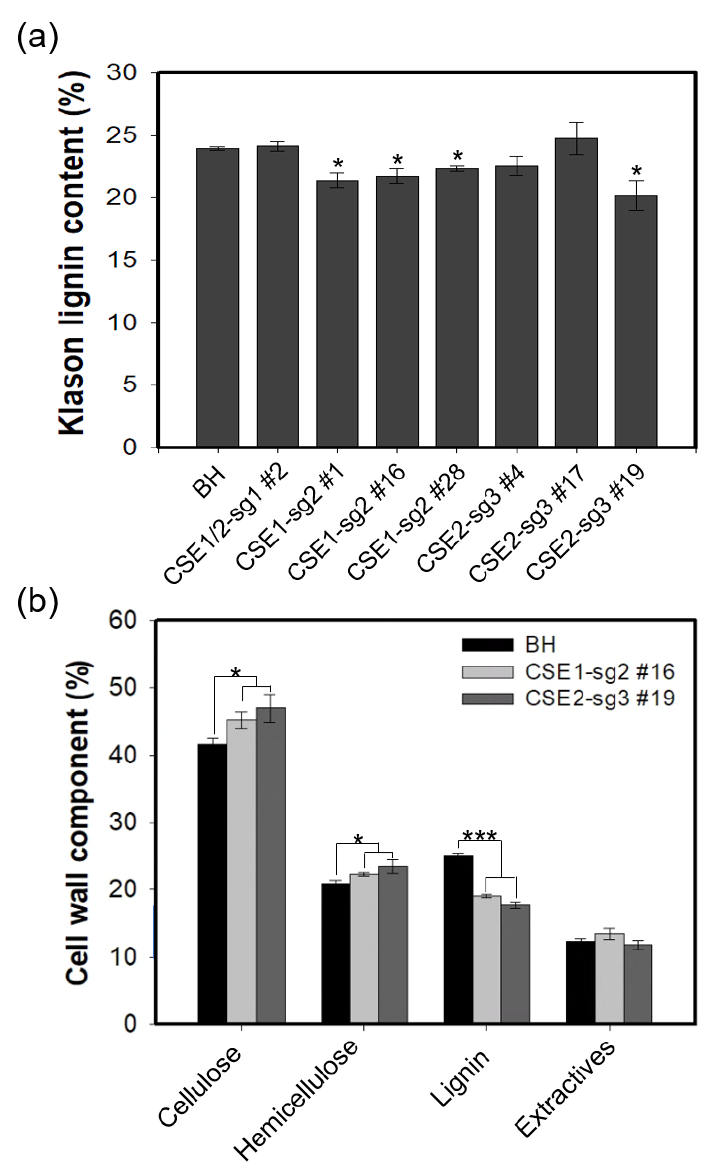
Figure 3. Transgenic CSE-CRISPR hybrid poplars have reduced lignin deposition. ( a ) Quantification of Klason lignin content. Two hundred milligrams of cell wall material from three-month-old hybrid poplars grown in pot was used ( n = 2, error bar = S.E.). ( b ) Cell wall composition analysis. Eight-month-old LMO field grown stem tissues were used to analyze the composition of cell wall components ( n = 3, error bar = S.E.). Asterisks indicate significant differences compared to BH using the unpaired Student’s t -test (* p -value < 0.05, *** p -value <